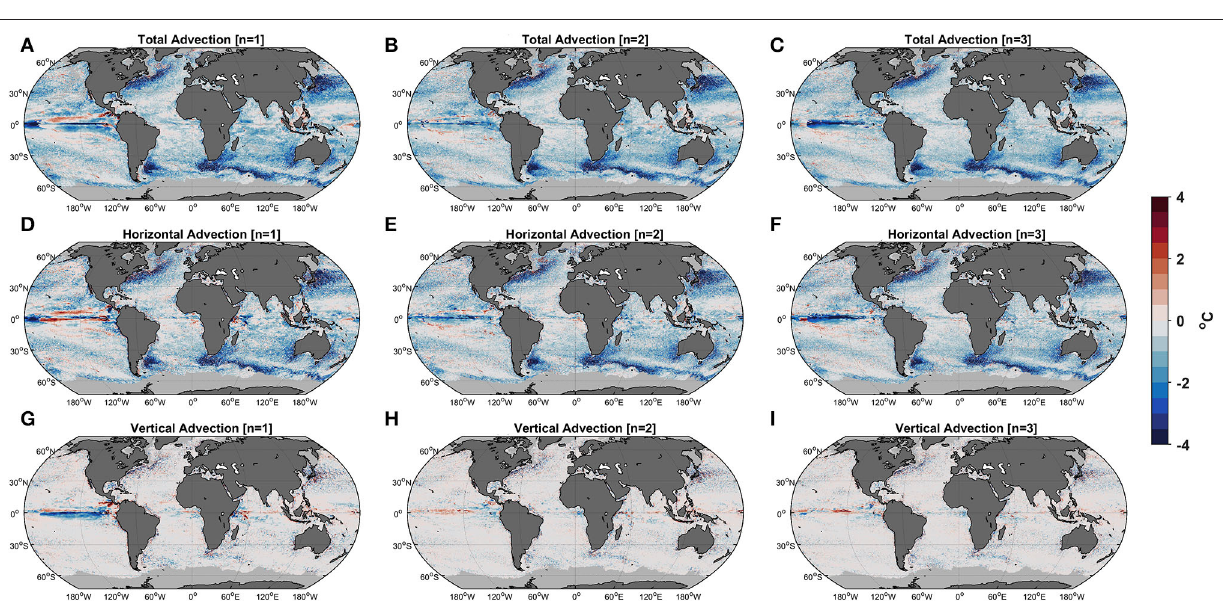
FIGURE 6 | The structure of the figure is the same as Figure 5 where the labeling is explained. Grid points where decay periods ended after Dec-31st 2014, or contaminated by sea-ice, were excluded from the analysis (gray